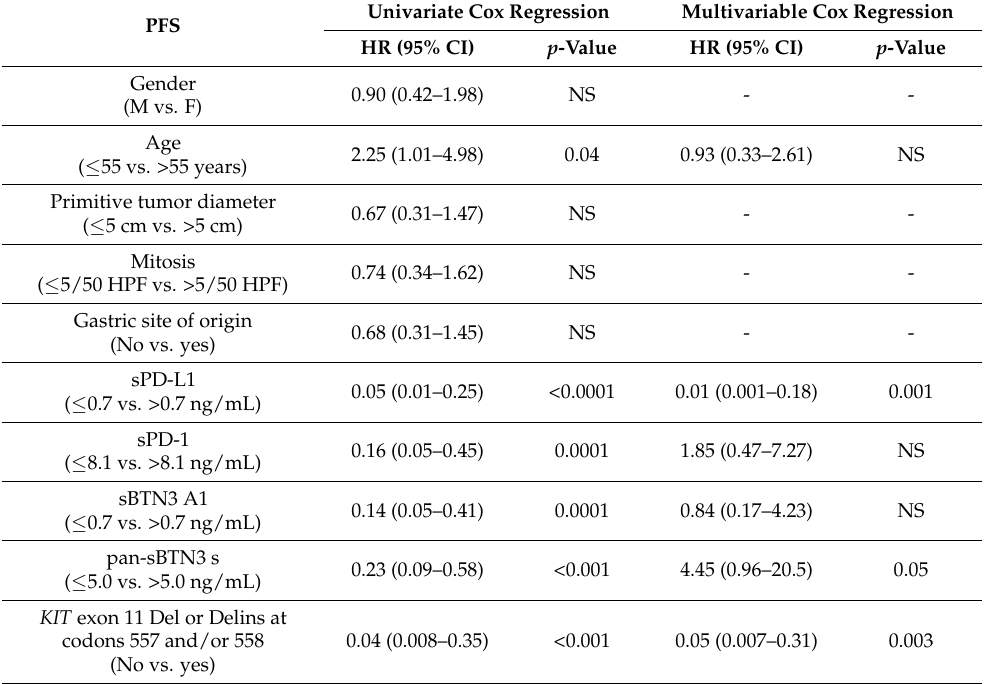
Table 3. Univariate and multivariate analysis of prognostic factors for PFS in KIT exon 11-mutated mGIST patients treated with first-line